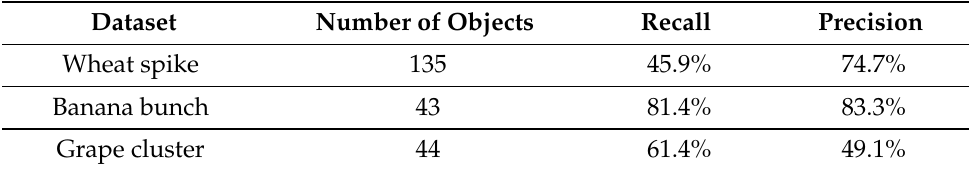
Table 3. Test set recall and precision of the object detectors.